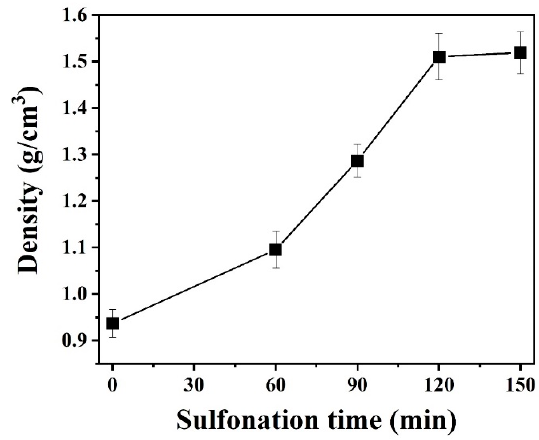
Figure 9. Density of the sulfonated LDPE / HDPE sheath-core fibers for various crosslinking times at 130 ◦